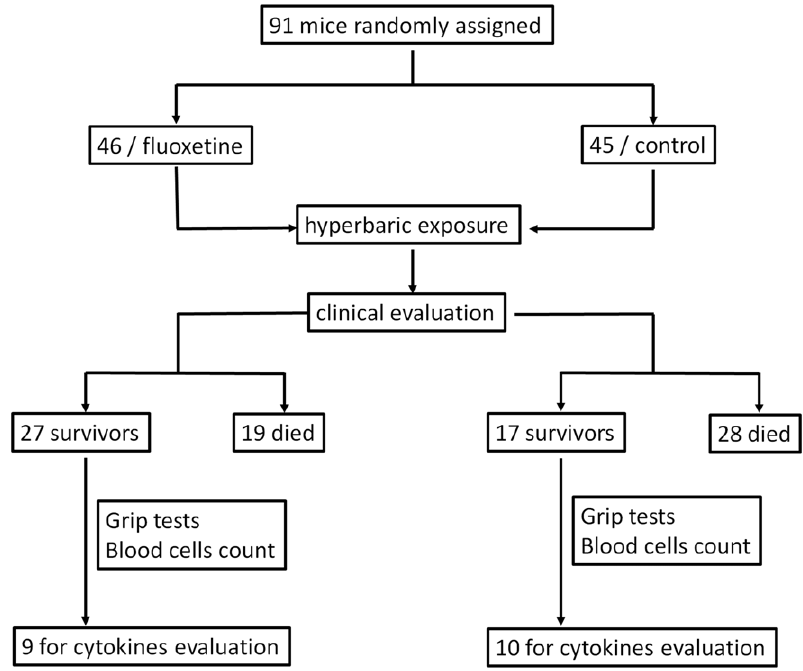
Figure 1. Flow chart describing the experimental design.